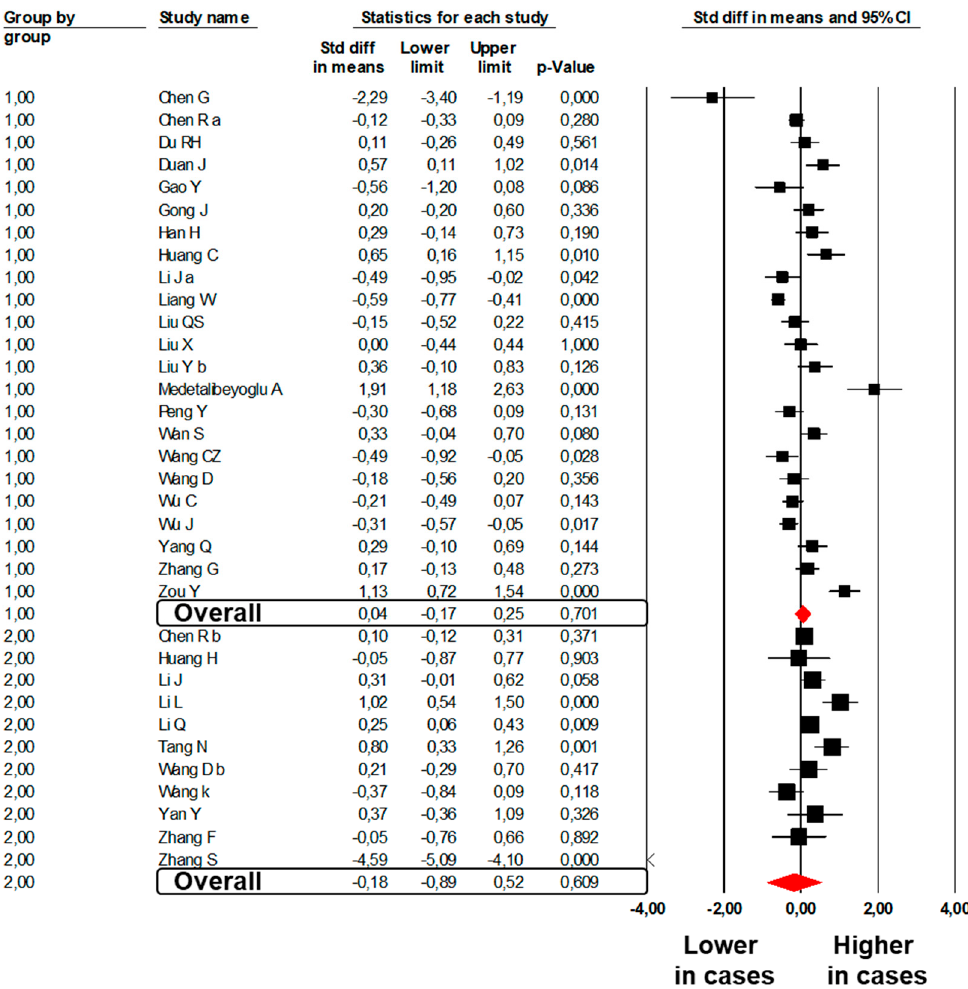
Figure 2. Forest plots of the difference in activated partial thromboplastin time values between subjects with severe and those with mild COVID-19 (Group 1) and between non-survivors and survivors to COVID-19 (Group 2).